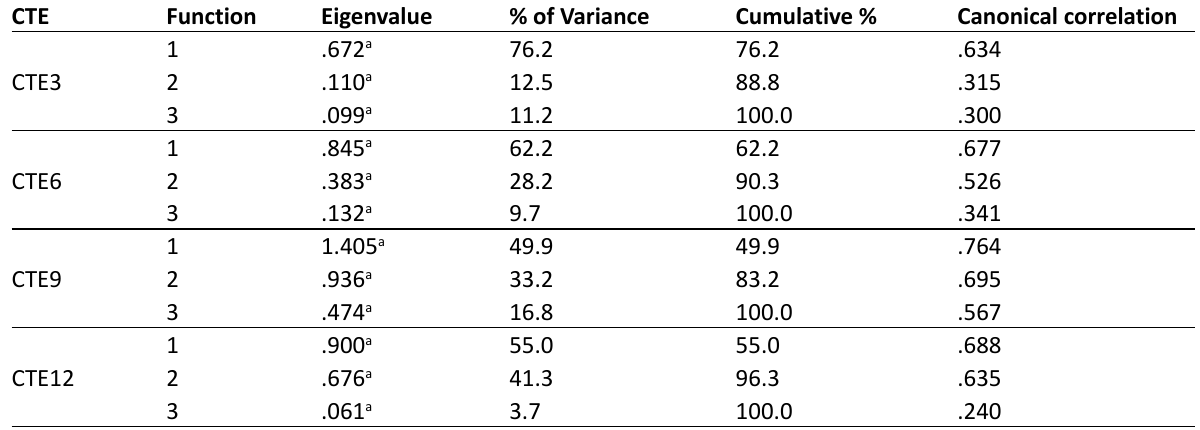
Table 3. Eigenvalues. Boys aged 8